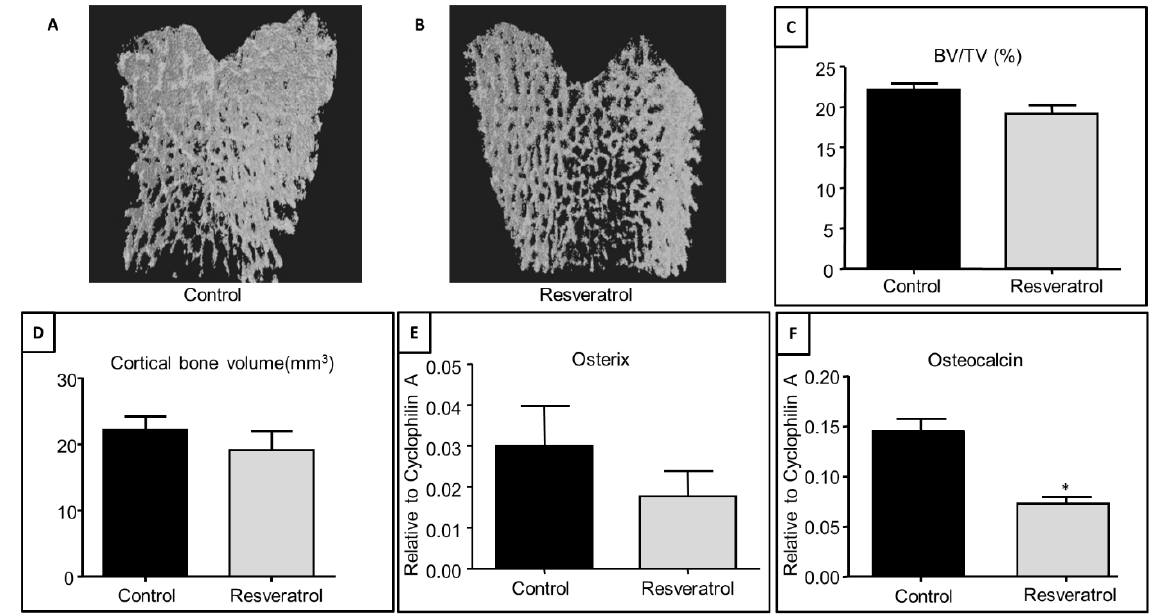
Figure 2. Effects of resveratrol supplementation on the trabecular bone structure and levels of mRNA expression of osteogenesis-related factors in the metaphysis of the tibial bone of ageing rats. 3D reconstruction images showing trabecular bone in ( A ) a control rat and ( B ) a resveratrol treated rat; ( C ) Effects on trabecular BV/TV from μ-CT analysis; ( D ) Effects on cortical bone volume from μ-CT analysis; ( E ) RT-PCR gene expression analyses for osterix ( p = 0.34); ( F ) RT-PCR gene expression analyses for osteocalcin ( p = 0.02). * p < 0.05 compared to control group, n =